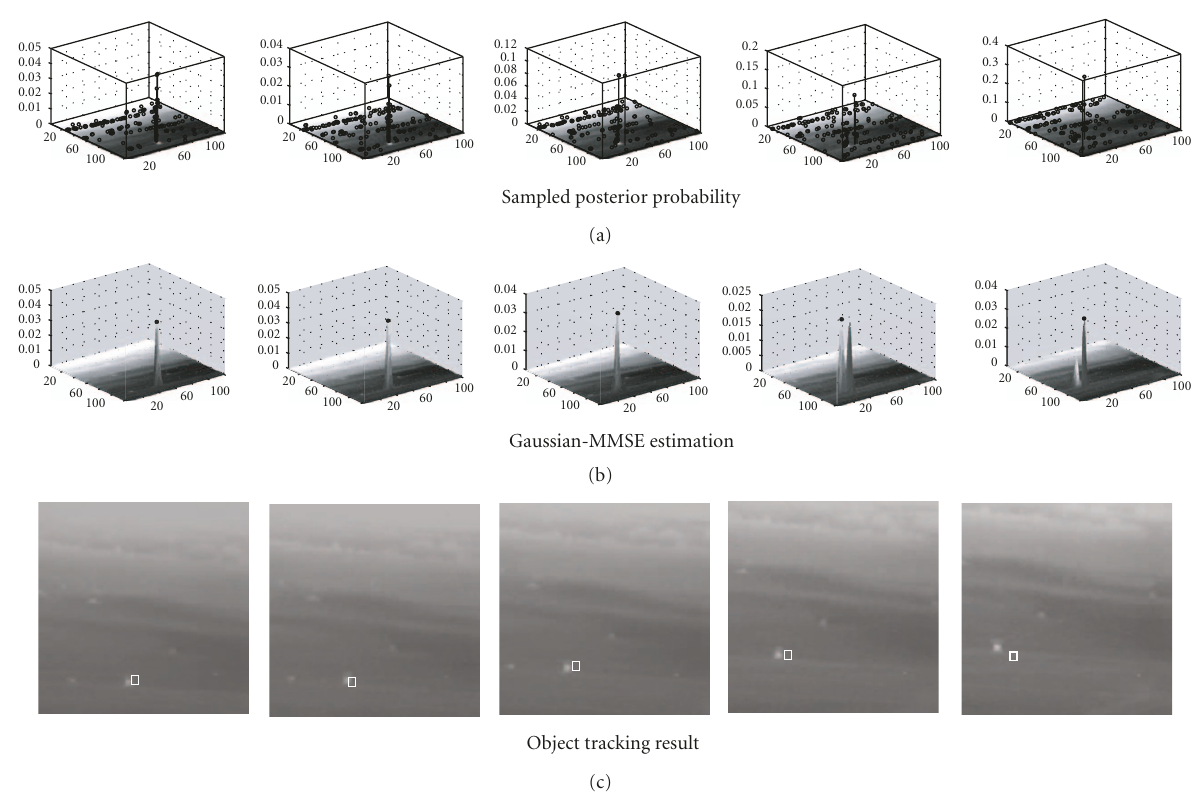
Figure 17: Tracking results for the DEH algorithm in a situation where the ego-motion compensation is especially challenging due to the aperture